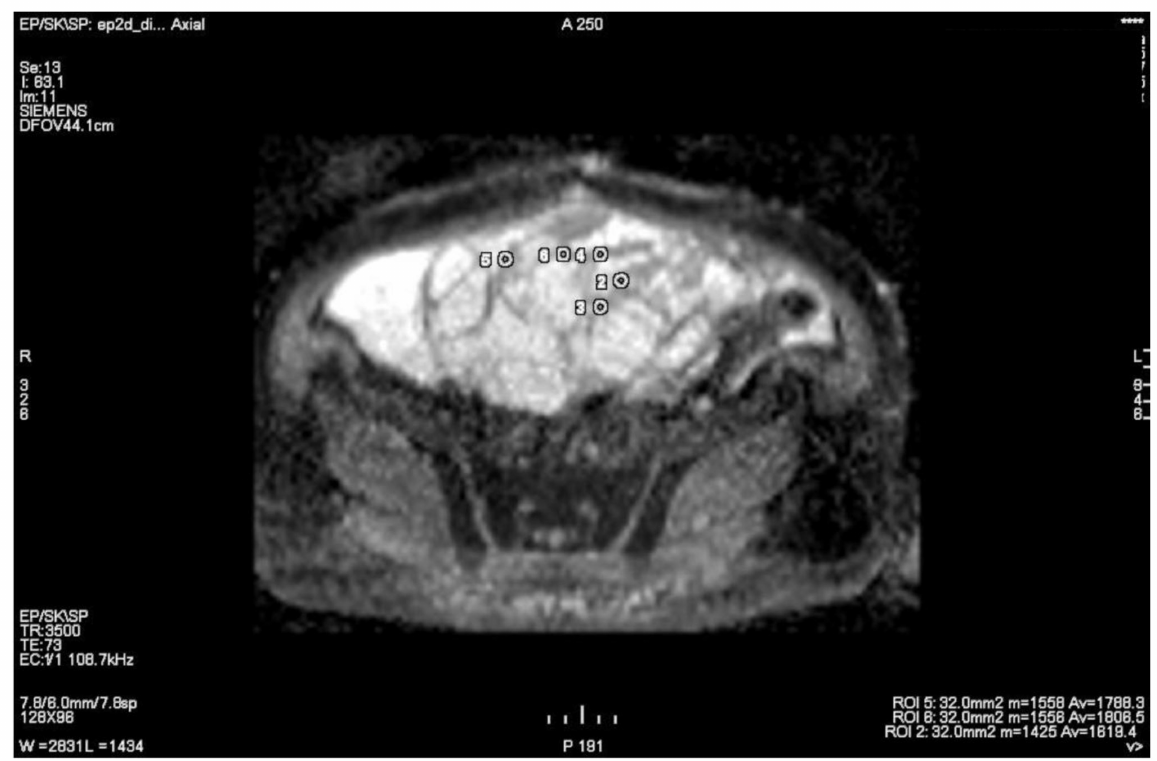
Figure 7. Images from a 59-year-old woman with low-grade serous ovarian cancer (LGSC). A multilocular cystic mass. Diffusion-ADC